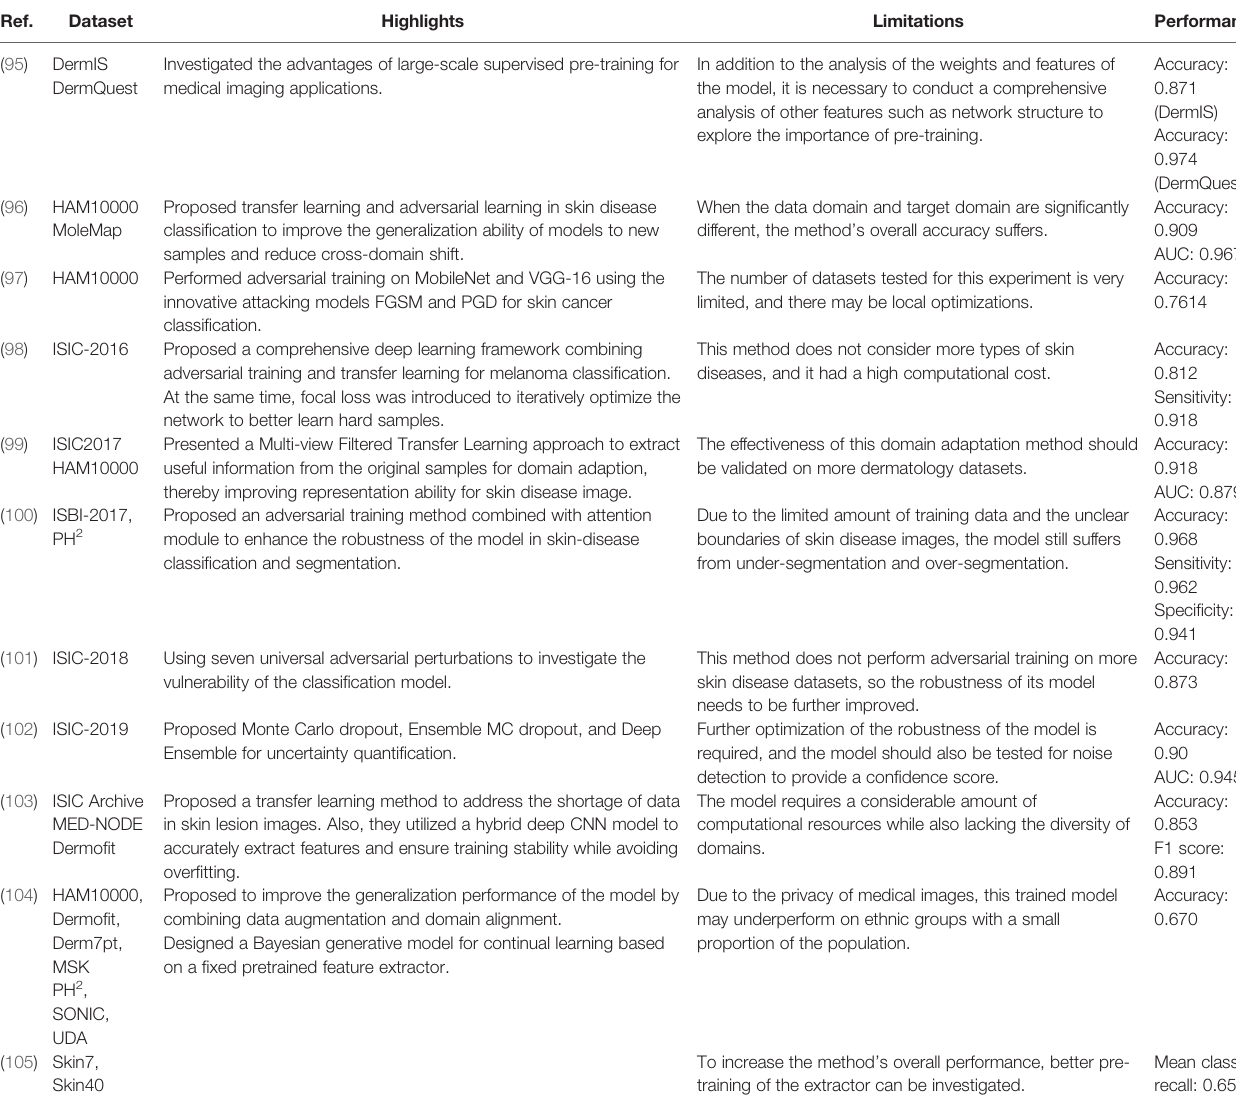
TABLE 5 | Different methods for improving model generalization ability and robustness.